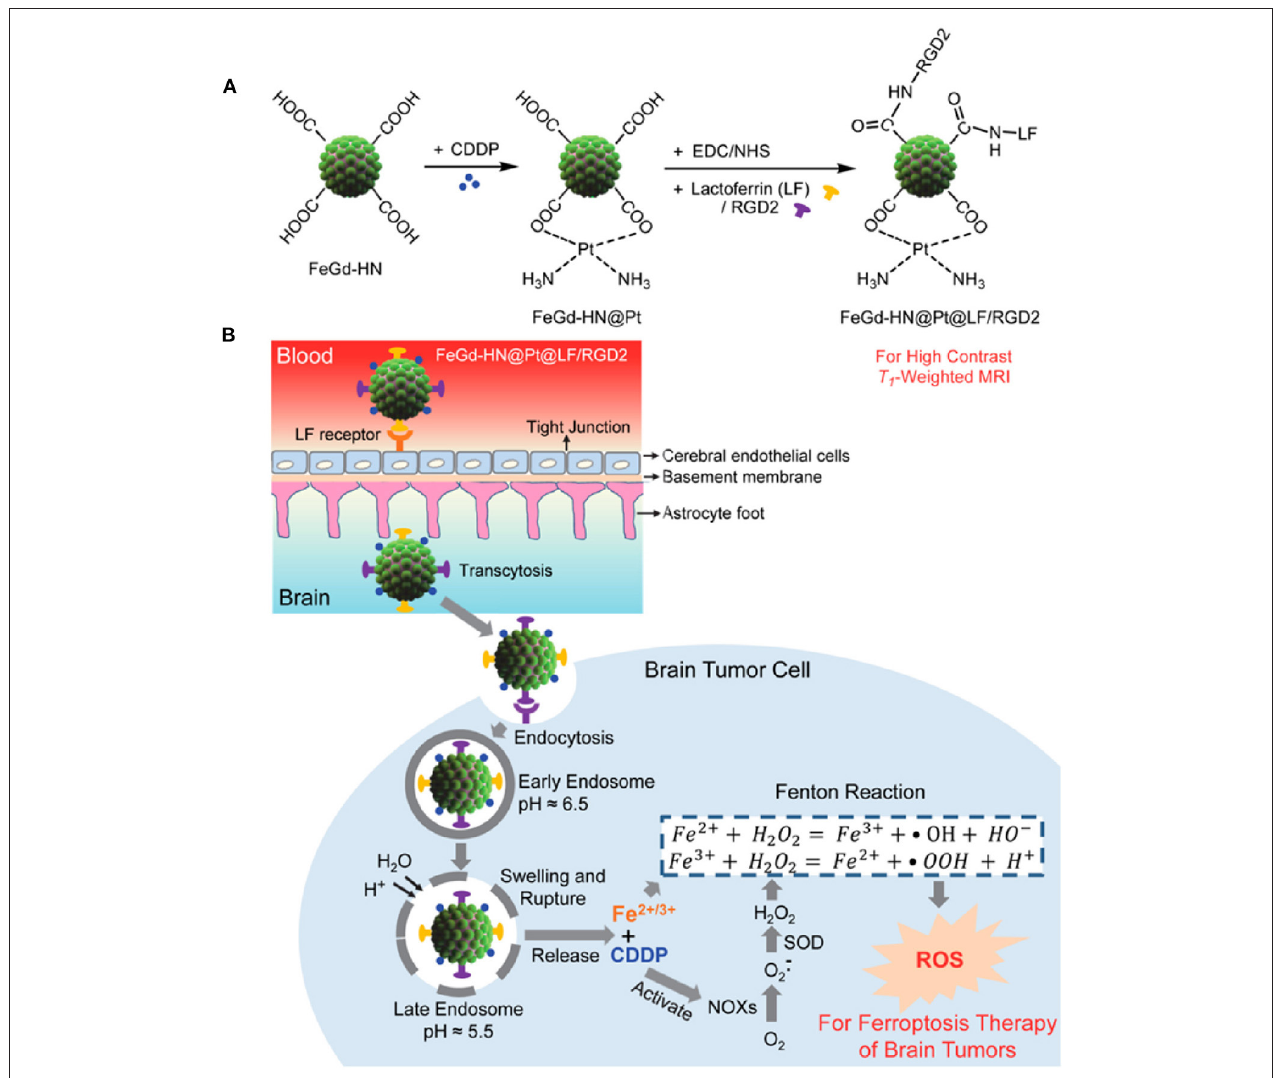
FIGURE 7 | Synthesis procedure of magnetic nanoparticle (A) . Mechanism of Brain tumor targeted IONP application in cancer cells via the Fenton reaction (B) . Reproduced with permission ( Shen et al., 2018). Copyright © 2018, American Chemical Society .